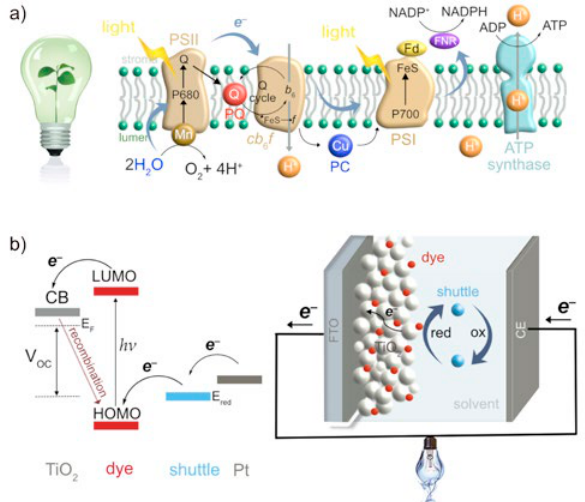
Figure 1. Schematic representation of the sequential electron trans- fer in (a) natural photosynthesis and (b) conventional dye-sensi- tized solar cells (pioneered by Grätzel at al. 8 ) inspired by natural photosynthesis. PS = photosystem; ADP = adenosine diphosphate; ATP = adenosine triphosphate; NADP = nicotinamide adenine dinucleotide phosphate; NADPH = reduced NADP; Q = quinone; PQ = plastoquinone; PC = plastocyanin; P680 and P700 = chloro- phyll pigments (P) of PSII and PSI, respectively, that best absorb light at either 680 nm or 700 nm, as indicated; Fd = ferredoxin; FNR = ferredoxin NADP reductase; CB = conduction band; LUMO = lowest occupied molecular orbital; HOMO = highest occupied molecular orbital; red = reduced; ox =